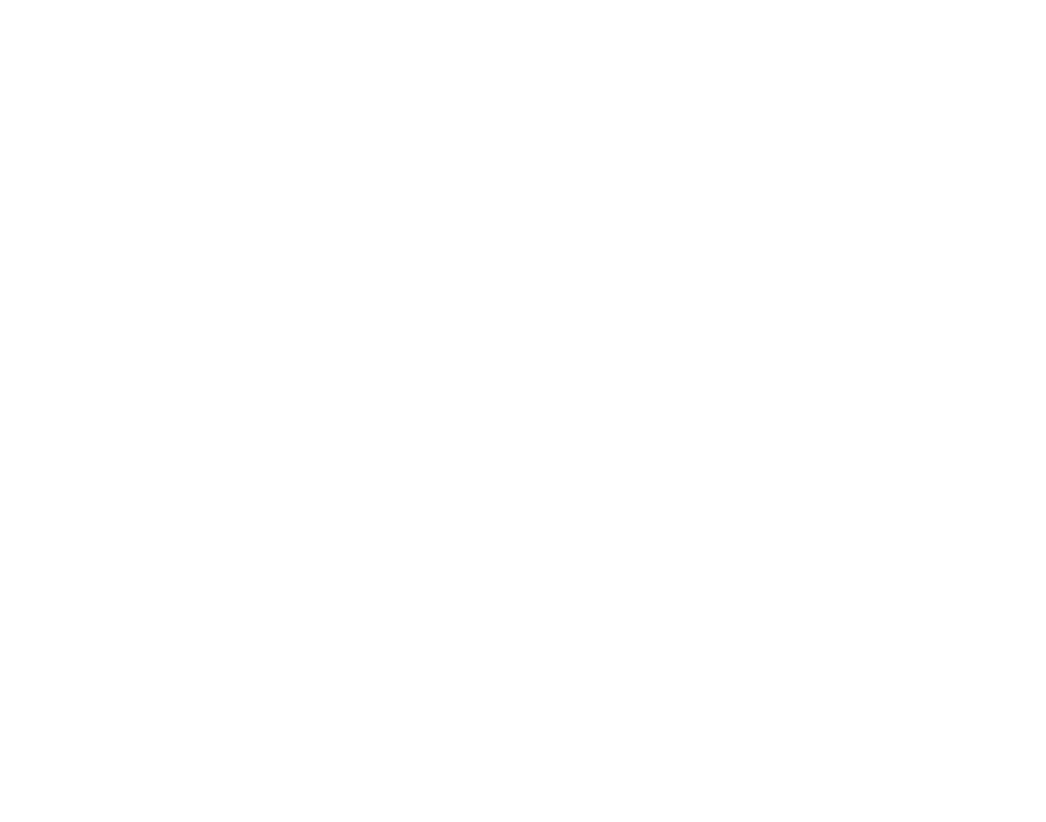
Figure 6. Absorption spectrum of the three-part-period grating with SFSS over the region from 1500 nm to 6000 nm, on the condition of ( a ) fixing f c = 0.2 and varying f a from 0.08 to 0.24; ( b ) fixing f a = 0.08 and varying f b from 0.200 to 0.067; ( c , d ) are the relationship between filling factors and the upper limit of absorption band corresponding to ( a , b ), respectively; ( e ) ultra-broadband absorption in our optimized structure from 750.0 nm to 5351.6 nm; electric field distributions at the wavelength of ( f ) 758.4 nm and ( g ) 5003.2